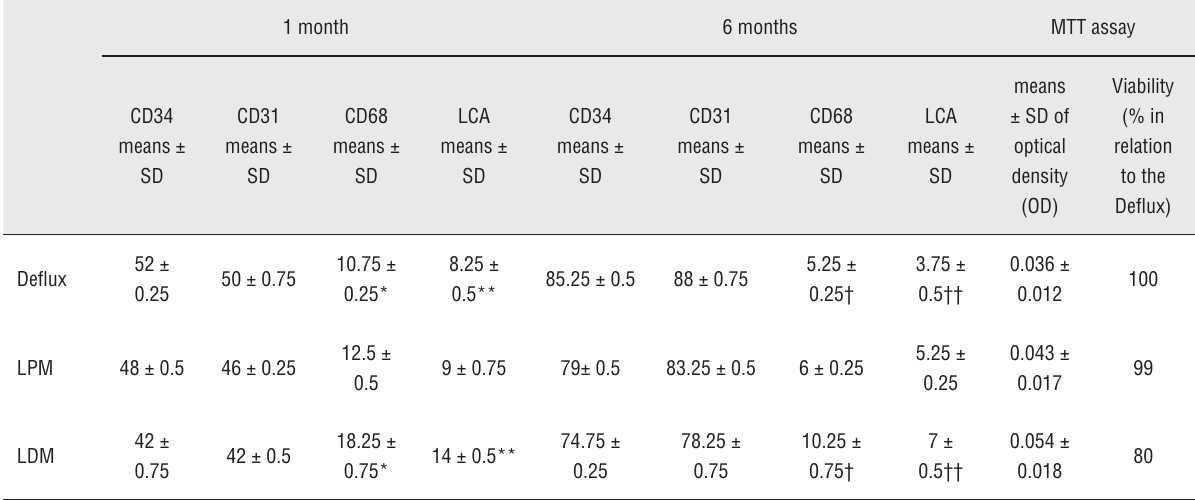
Table 1 - Immunohistochemical comparison of different bulking agents after 1 and 6 months of injection, and the results of MTT assay for in-vitro evaluation of cell viability in three different bulking